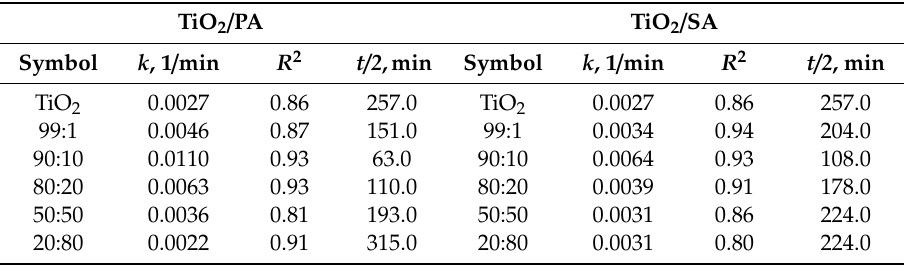
Table 4. Impact of the TiO 2 modification on the pseudo first-order